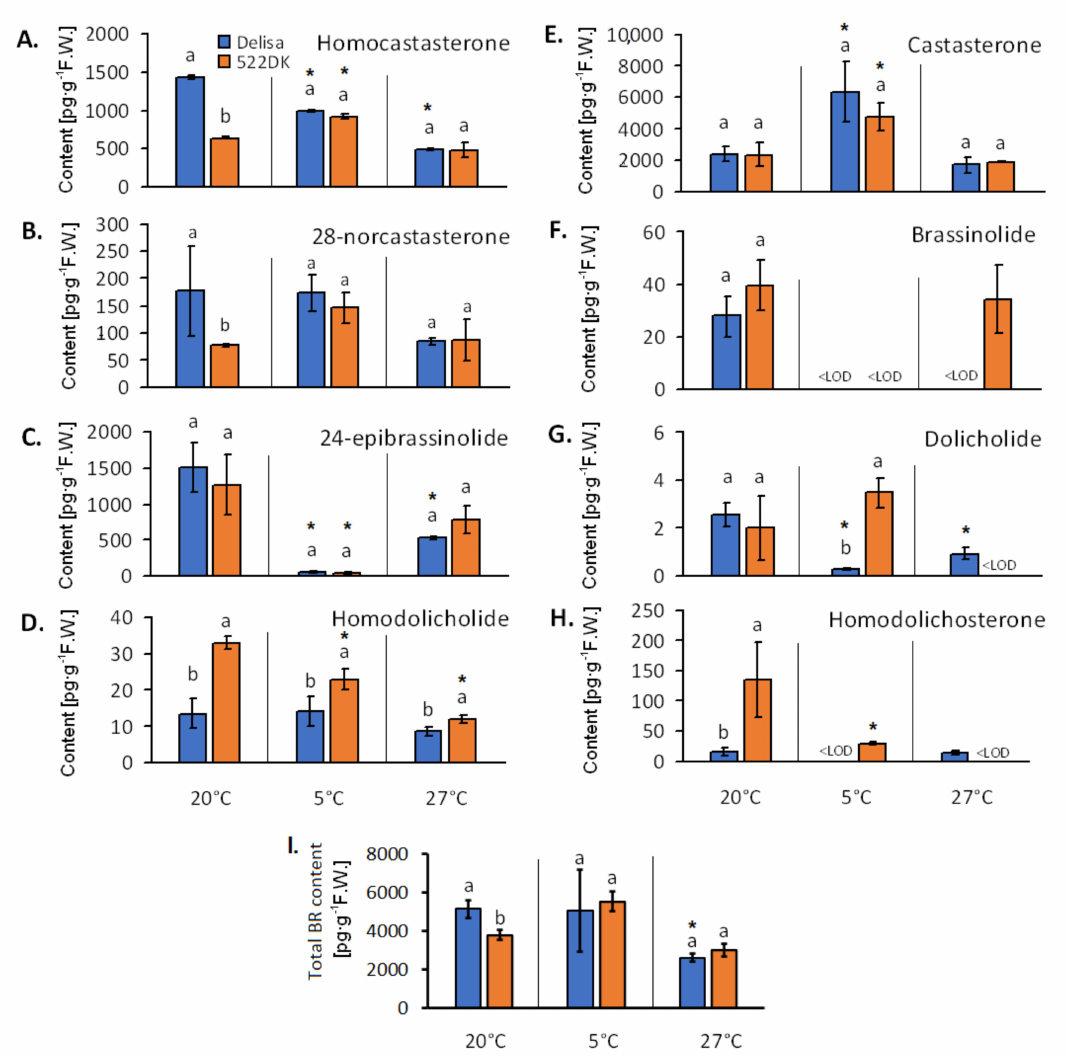
Figure 3. Content of brassinosteroids in the chloroplasts of the barley wild-type Delisa and the BR-deficient mutant 522DK that had been grown at 20 ◦ C and acclimated at 5 ◦ C or 27 ◦ C. ( A ) Homocastasterone, ( B ) 28-norcastasterone, ( C ) 24–epibrassinolide, ( D ) Homodolicholide, ( E ) Castasterone, ( F ) Brassinolide, ( G ) Dolicholide, ( H ) Homodolichosterone, ( I ) Total BR content. <LOD–below detection limit. Mean values ( ± SD) marked with the same letters are not significantly different according to Student’s t-test ( p ≤ 0.05) (separately for each growth temperature). Additionally, in order to show the impact of temperature on the BR level in Delisa and mutant, the comparisons (Student’s t -test, p ≤ 0.05) were performed in pairs (Delisa at 20 ◦ C and 5 ◦ C; mutant at 20 ◦ C and 5 ◦ C; Delisa at 20 ◦ C and 27 ◦ C; mutant at 20 ◦ C and 27 ◦ C) and any significant differences are indicated by an